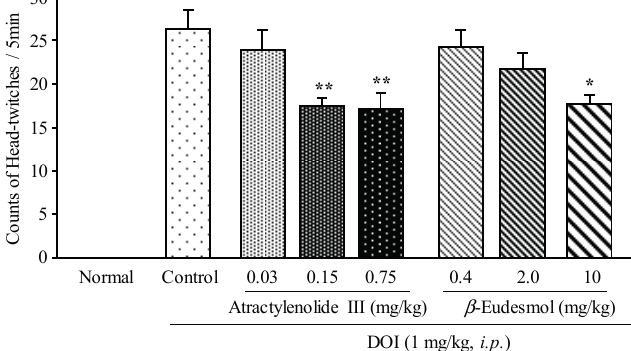
Figure 3. Effect of atractylenolide III and β -eudesmol on DOI-induced HTR in mice. Each column represents the mean ± S.E. of 9 mice. * p < 0.05, ** p < 0.01 vs. Control